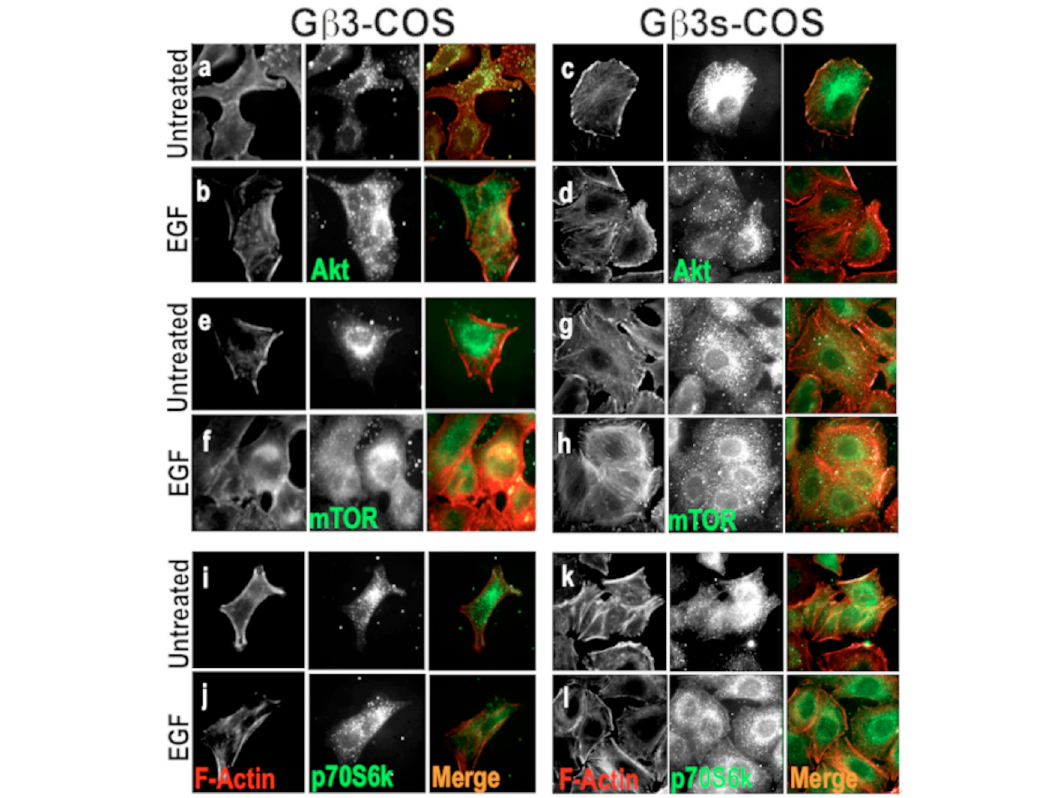
Figure 7. Gβ3s subunit displaces AKT away from actin stress fibers. F-actin staining using Alexa fluor 568 conjugated phalloidin and co-immuno staining using antibodies against total AKT1, mTOR and p70 S6k and subsequent relevant secondary antibody conjugated to alexafluor-488 was performed for both G b 3-COS and G b 3s-COS cells (a-i). While G b 3-COS exhibit co-localisation between F-actin and AKT1, G b 3s-COS cells fail to show such co-localisation both in untreated and EGF treated states (compare a & b with c & d). G b 3s-COS cells exhibit enhanced co-localisation of mTOR and p70 S6K with F-Actin stress fibers as compared to G b 3-COS cells (compare g, h, k & l with e, f I & j respectively). Images are representative of several images taken from different fields of view under 40x objective with further 1.5x magnification. Bar = 13 m m. Data are the mean with standard error (bars) of n=3 independent experiments (n). Statistical significance is shown as *P<0.05, **P<0.01,